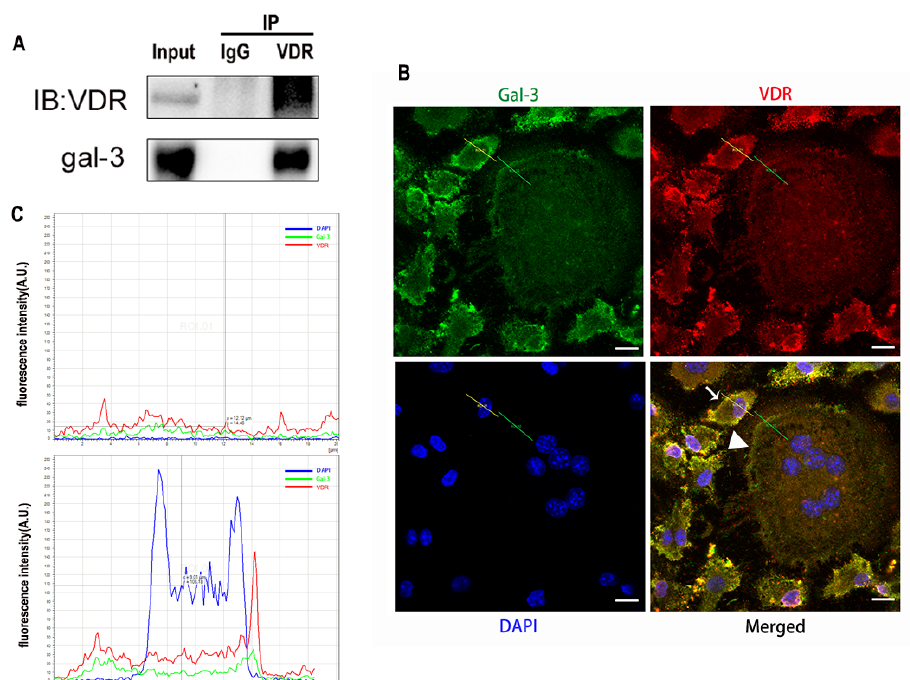
Figure 10. Images showing co-localization and possible interactions between gal-3 and VDR proteins. ( A ) Interaction between gal-3 and VDR proteins confirmed by co-immunoprecipitation. ( B , C ) Co-localization of gal-3 and VDR proteins detected by immunofluorescence. In non-merged images, gal-3 is green, VDR is red, and nuclei are blue. Bars = 10 μ m.